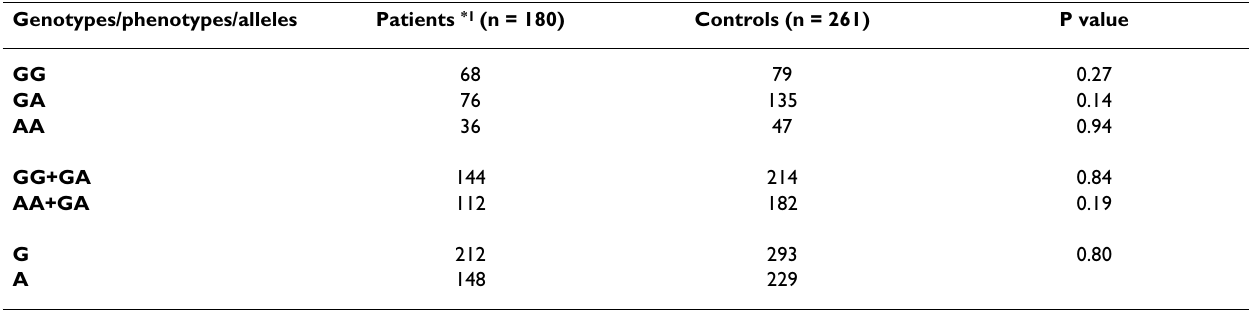
Table 4: Genotyping of rs2076530 in the BNTL2